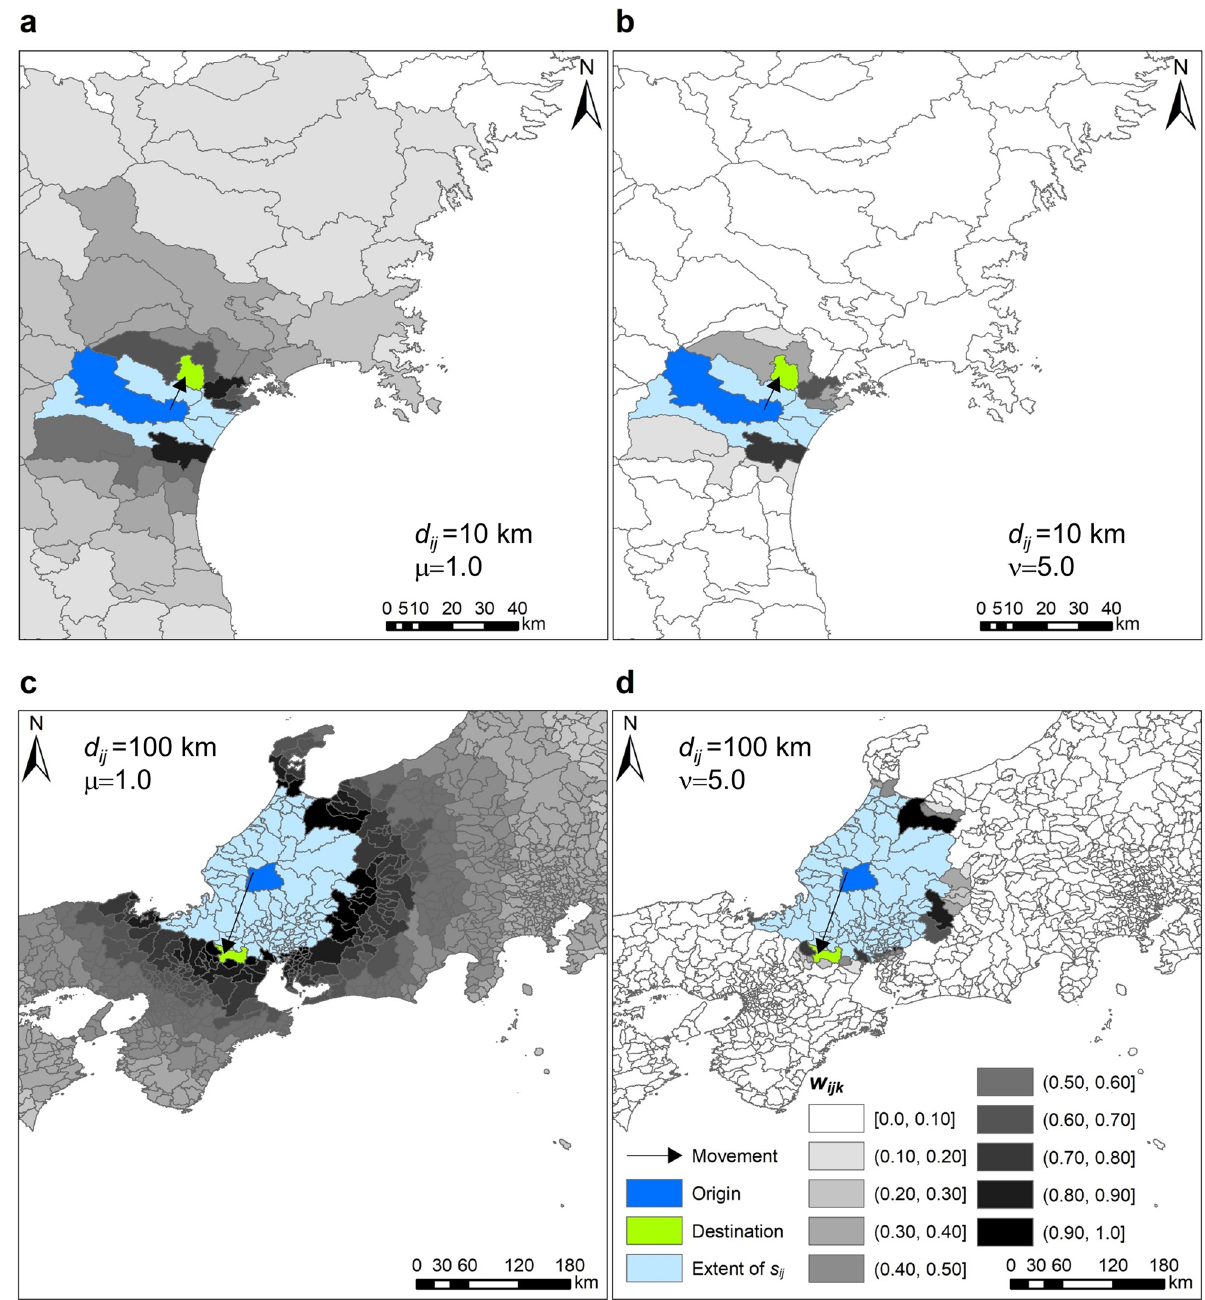
Figure 4. Empirical examples of weighting kernel functions based on Japanese municipalities and distance between population centres of those. ( a , b ) example in which the distance between the population centres of origin and destination is approximately 10 km, and ( a ) and ( b ) are corresponding to the kernel function in the case of µ = 1.0 and ν = 5.0 , respectively. ( c , d) same as ( a , b ), but the distance is approximately 100 km, and ( c ) and ( d ) are corresponding the case of µ = 1.0 and ν = 5.0 respectively. The map in this figure was created with ArcGIS version 10.7 (http://deskt op.arcgi